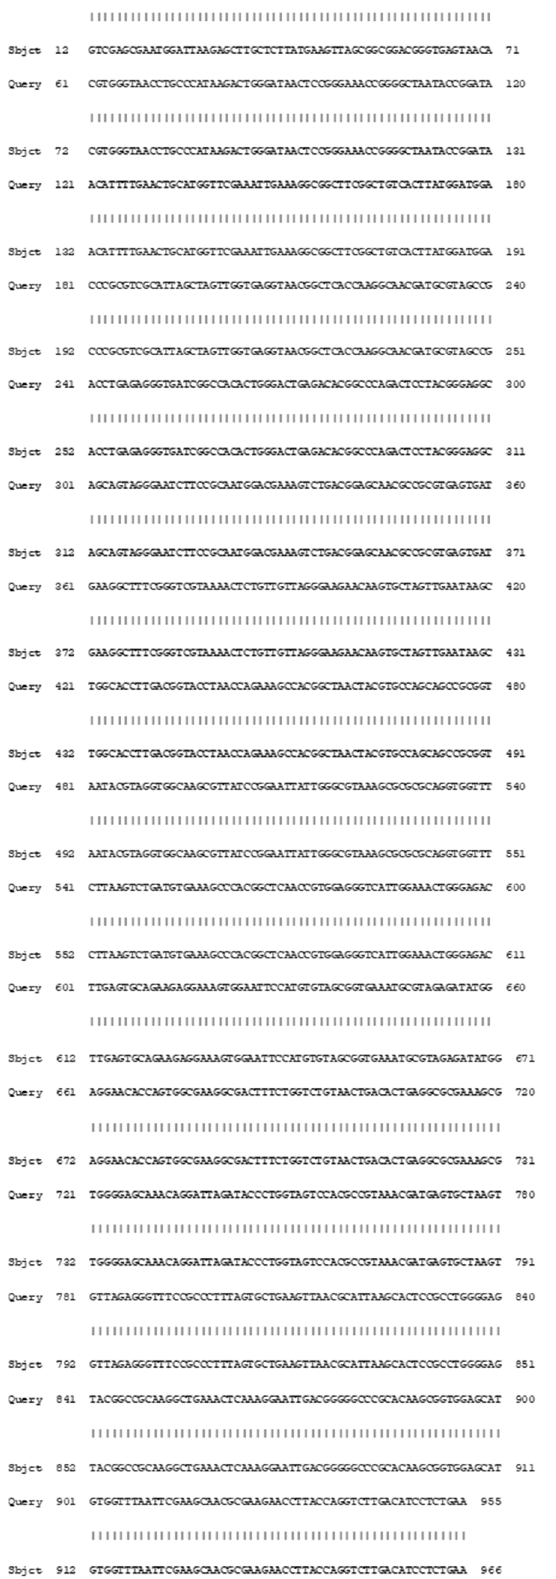
Figure 1. Sequence alignment of the isolate AS-02 “OK576278” (Query) against the 16S rRNA gene sequence data of Bacillus wiedmannii strain J5BS1 “MT415972.1” (Sbjct) in GenBank, showing NO base substitutions.